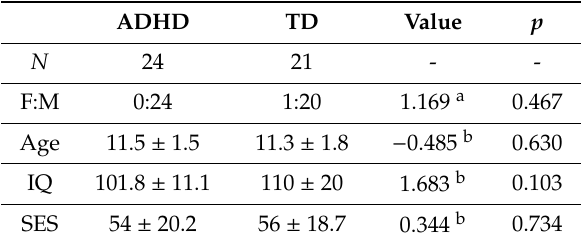
Table 1. Sample demographic characteristics.